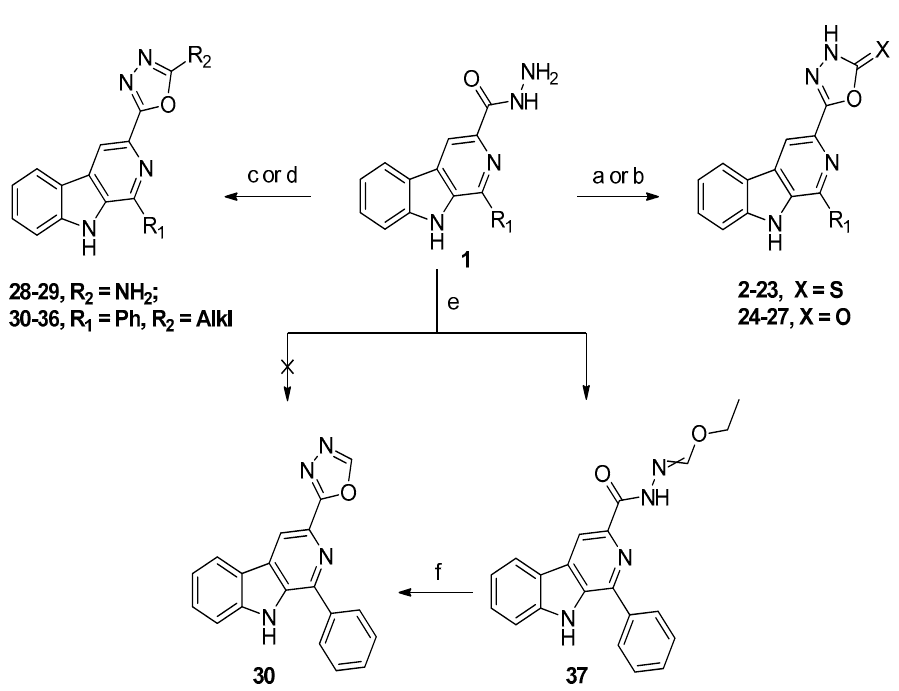
Figure 2. Synthesis of β -carboline 1,3,4-oxadiazole derivatives 2 – 37 . Reagents and conditions: (a) For compounds 2 – 23 : i: CS 2 , KOH, EtOH, reflux, 24 h; ii: acidified 2N HCl; (b) For compounds 24 – 27 : triphosgene, CH 2 Cl 2 , reflux, 2 h; (c) For compounds 28 and 29 : BrCN, NaHCO 3 , dioxane, water, r.t., 4 h; (d) For compounds 30–36 : acid, phosphorus oxychloride, reflux, 4–6 h; (e) triethyl orthoformate, reflux, overnight; and (f) pyridine, reflux, 12 h.